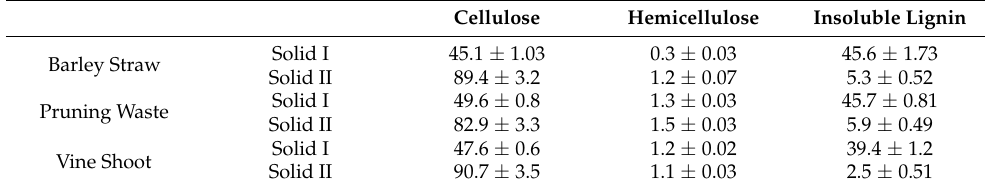
Table 4. Composition analysis (wt.%) of recovered solids. Samples dried at 105 ◦ C.